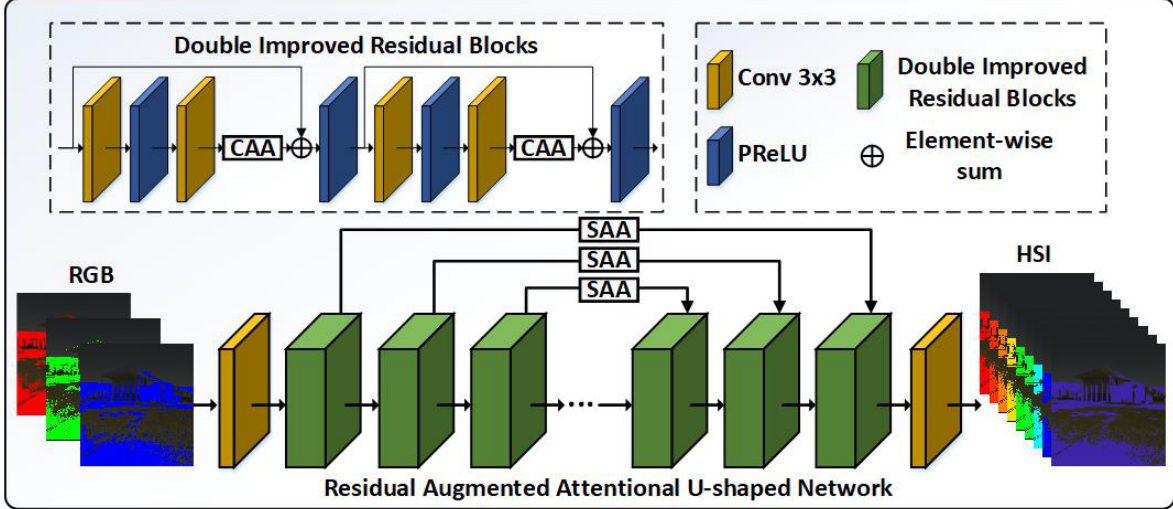
Figure 1. Network architecture of the proposed RA 2 UN network. The input of the RA 2 UN network is RGB images and the output is the corresponding reconstructed HSIs. The detailed network and parameters setting can be referenced from Table